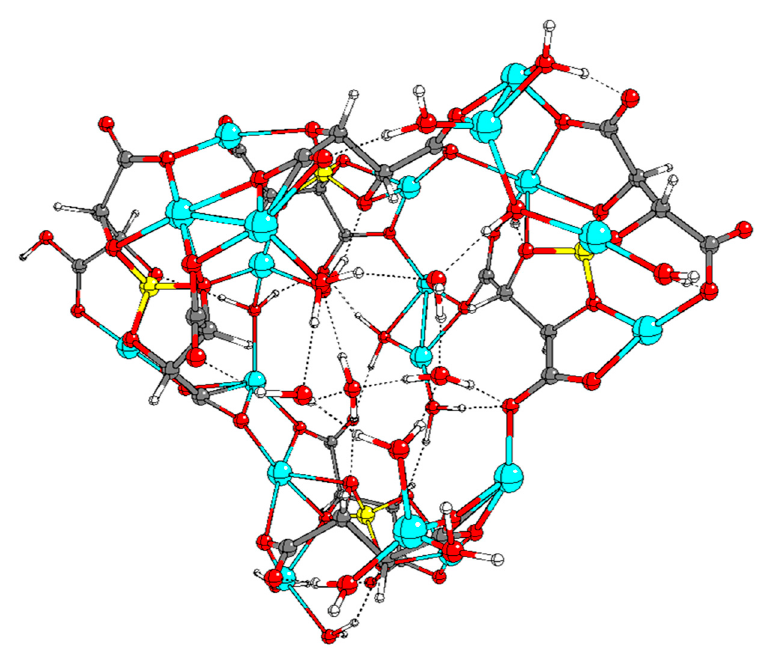
Figure 3. View of the asymmetric unit of compound Li 5 T 2 B.